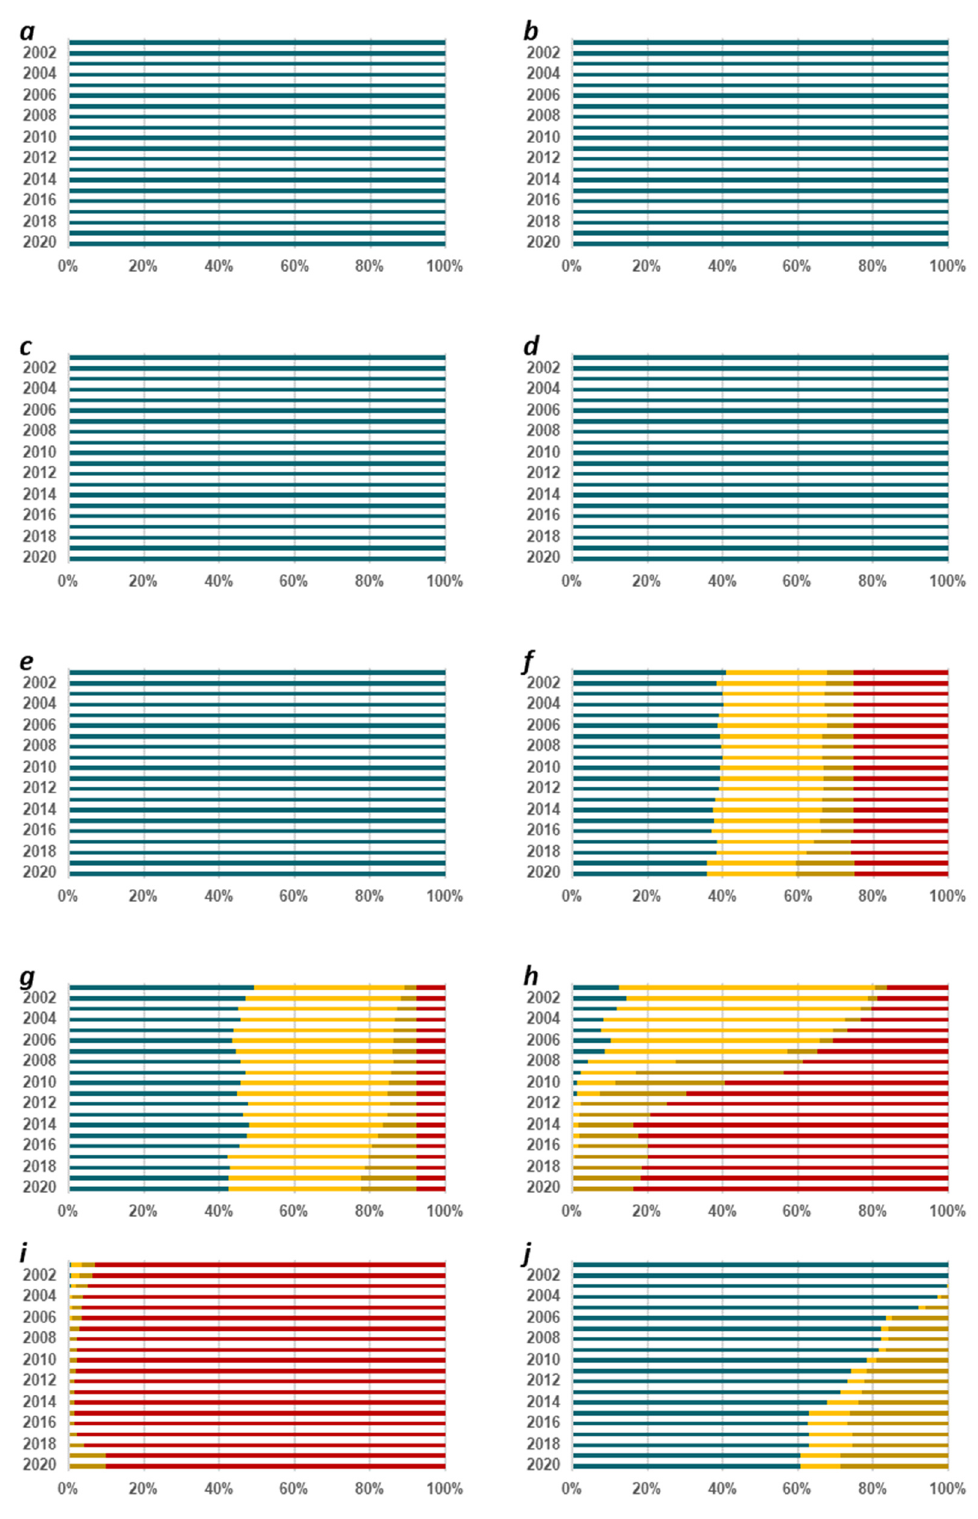
Figure 3. Annual percentage of land cover type in forested and deforested areas in the Chiquitania region (2001–2020). Sites with intact forest: ( a ) Noel Kempff, ( b ) Bajo Paraguá, ( c ) Monteverde, ( d ) San Rafael, and ( e ) Tucabaca. Sites with deforestation: ( f ) San Ignacio, ( g ) Concepción, ( h ) El Cerro/California, ( i ) Nueva Esperanza, and ( j ) Santa Ana/Buena Vista.